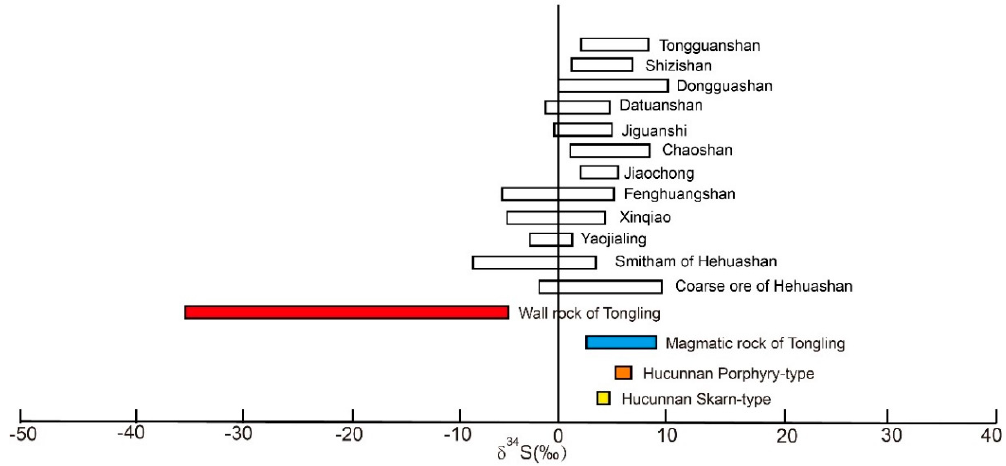
Figure 14. Distribution of sulfur isotope (data after [76–92]).